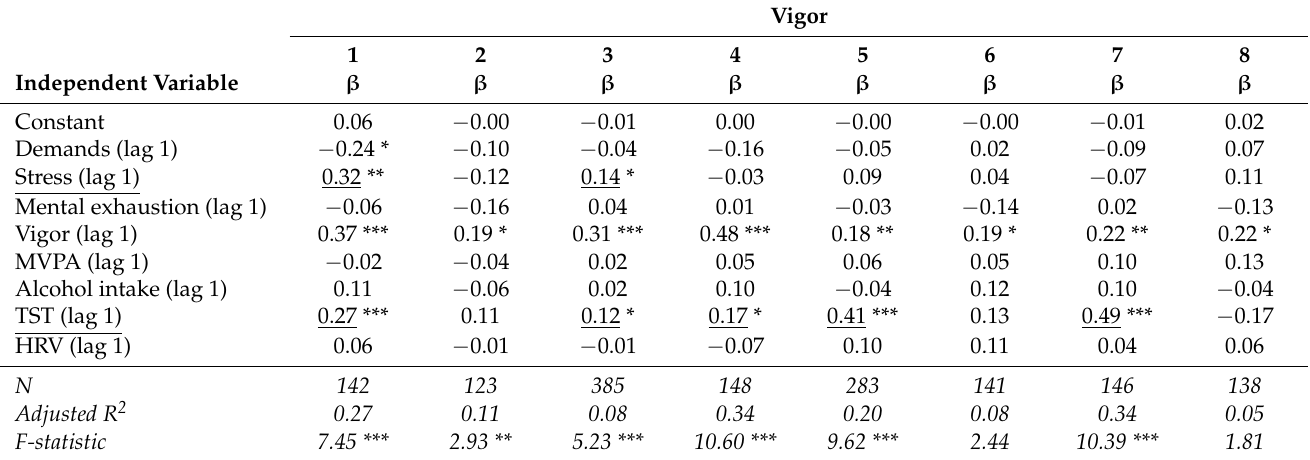
Table 7. Vector autoregression models for vigor per participant (1–8).